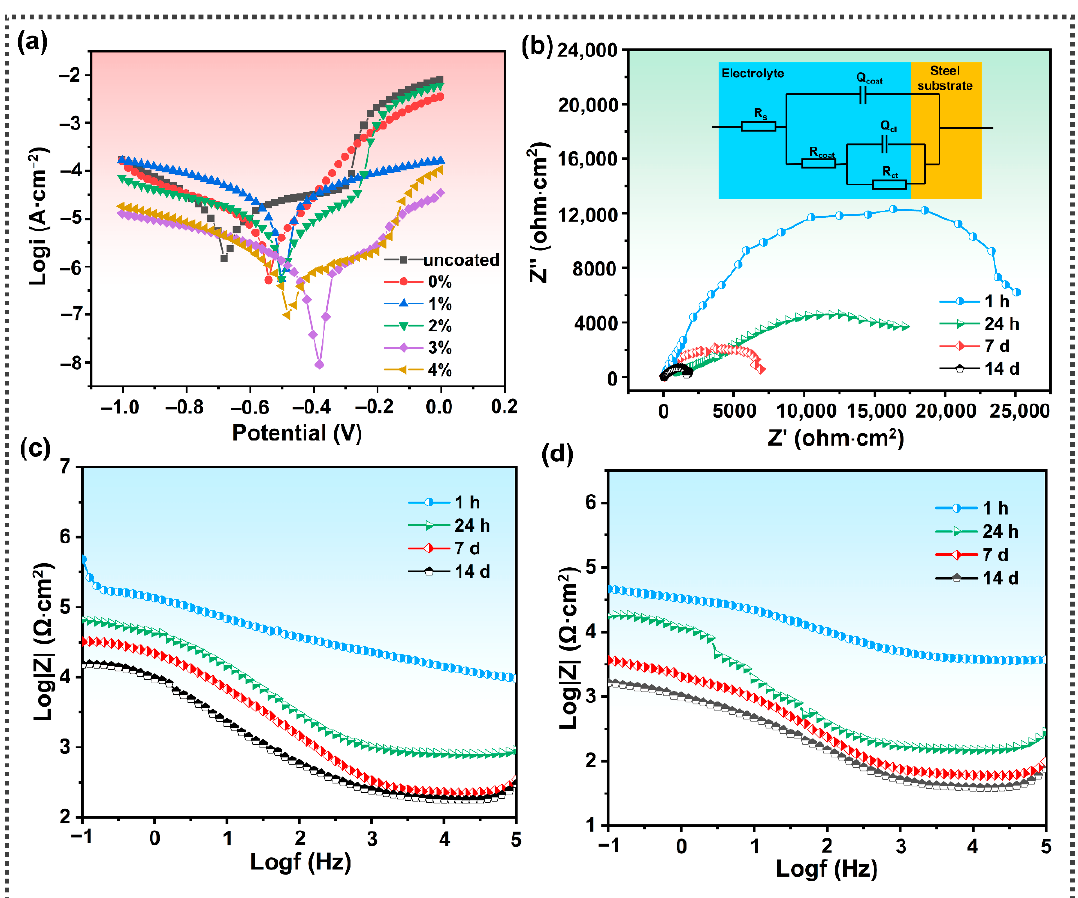
Figure 7. ( a ) Tafel polarization curves of the bare steel sheets and the coated steel sheets with different CNT contents immersed in a 3.5 wt% NaCl solution. ( b ) Nyquist plots of the SFPUHE-HTF-CNTs-3-coated steel sheets immersed in a 3.5 wt% NaCl solution for 1 h, 24 h, 7 d and 14 d; the inset is the equivalent circuit used to fit the EIS data. ( c ) Bode modulus plots of the SFPUHE-HTF-CNTs-3-coated steel sheets immersed in a 3.5 wt% NaCl solution for 1 h, 24 h, 7 d, 14 d. ( d ) Bode modulus maps of the repaired SFPUHE-HTF-CNTs-3-coated steel sheets immersed in a 3.5 wt% NaCl solution for 1 h, 24 h, 7 d, 14 Table 1. Fitting results of EIS data for bare steel and coated steel immersed in a 3.5 wt% NaCl solu- tion for 1 h, 24 h, 7 d and 14 d.